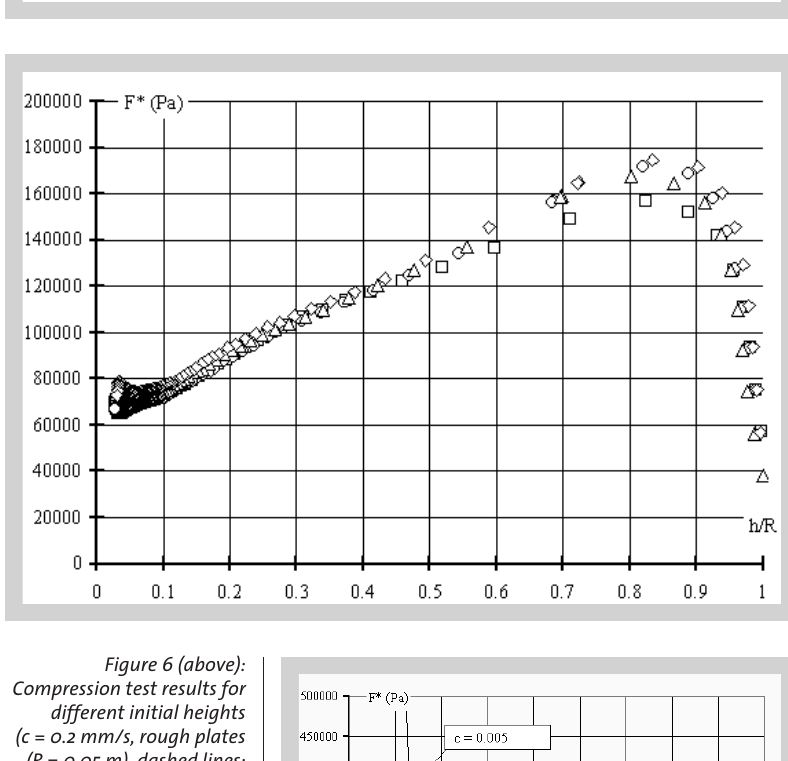
Figure 6 (above): Compression test results for different initial heights (c = 0.2 mm/s, rough plates (R = 0.05 m), dashed lines: uncertainty (risk 32%), solid lines: experimental average value). Figure 7 (middle): Compression test results (natural soil, rough plates (R = 0.05 m), Á : c = 0.2 mm/s, Û : c = 0.4 mm/s, Ì : c = 0.6 mm/s, · : c = 1.0 mm/s). Figure 8 (below): Consolidation phenomena taking place for very low compression speeds (extruded Kaolinite pastes with initial w =